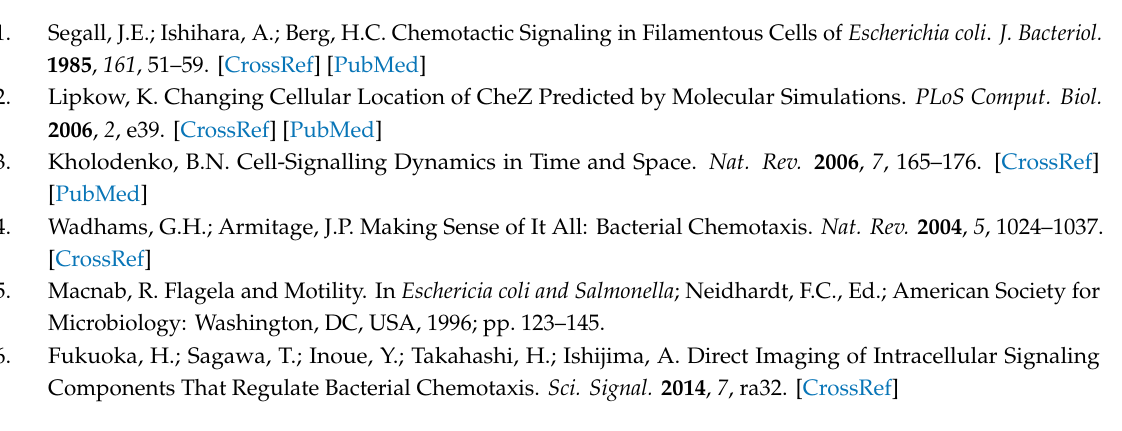
Supplementary Methods, Table S1: Bacterial strains and plasmids, Figure S1: The switching coordination between two motors in CheA S − cell measured at 1255 fps, Figure S2: The switching coordination between two motors in a mutant cell, which has the substitution for F98S in CheZ (CheZ(F98S) cell), Figure S3: Schematic diagram of the measurement system to measure the cellular response time to serine signal photoreleased from caged serine, Figure S4: Simulation for the change in CheY-P concentration in the presence and absence of the polar localization of CheZ, Figure S5: Simulation for the coordination of the directional switching between motors [38,39]. Author Contributions: All measurements and data analysis were carried out by Y.-S.C. and H.F. Strains